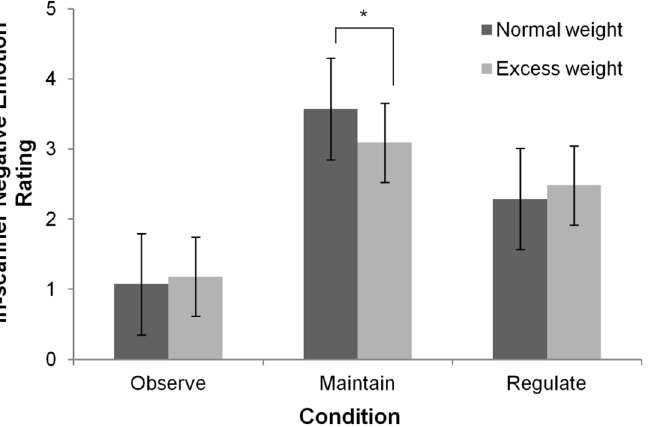
Fig 2. In-Scanner Negative Emotion Intensity Ratings. Mean (95% Confidence Interval) in-scanner negative emotion ratings elicited during each condition (Observe, Maintain and Regulate) (n = 28) * p < 0.05.